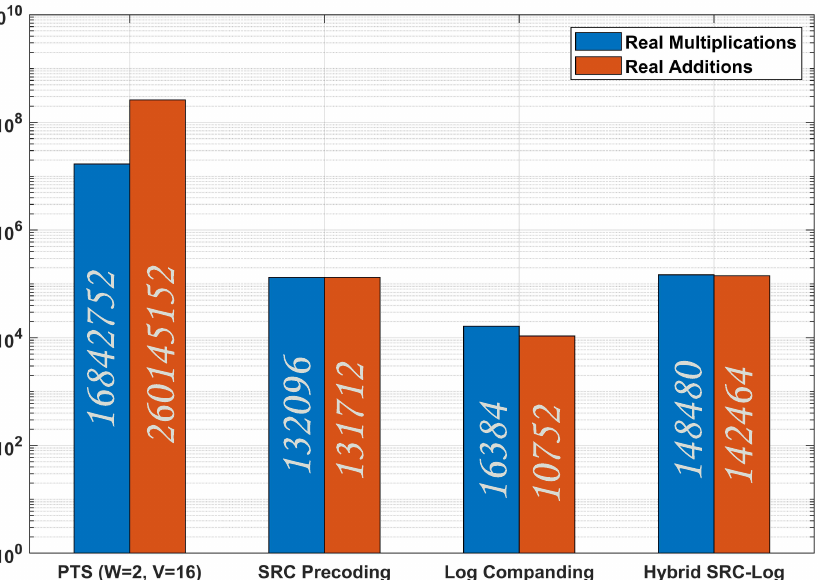
Figure 13. Comparison of computational complexity of SRC, Log, and Hybrid SRC-Log, based on (17), (19), along with PTS [15] with V = 16 and W =